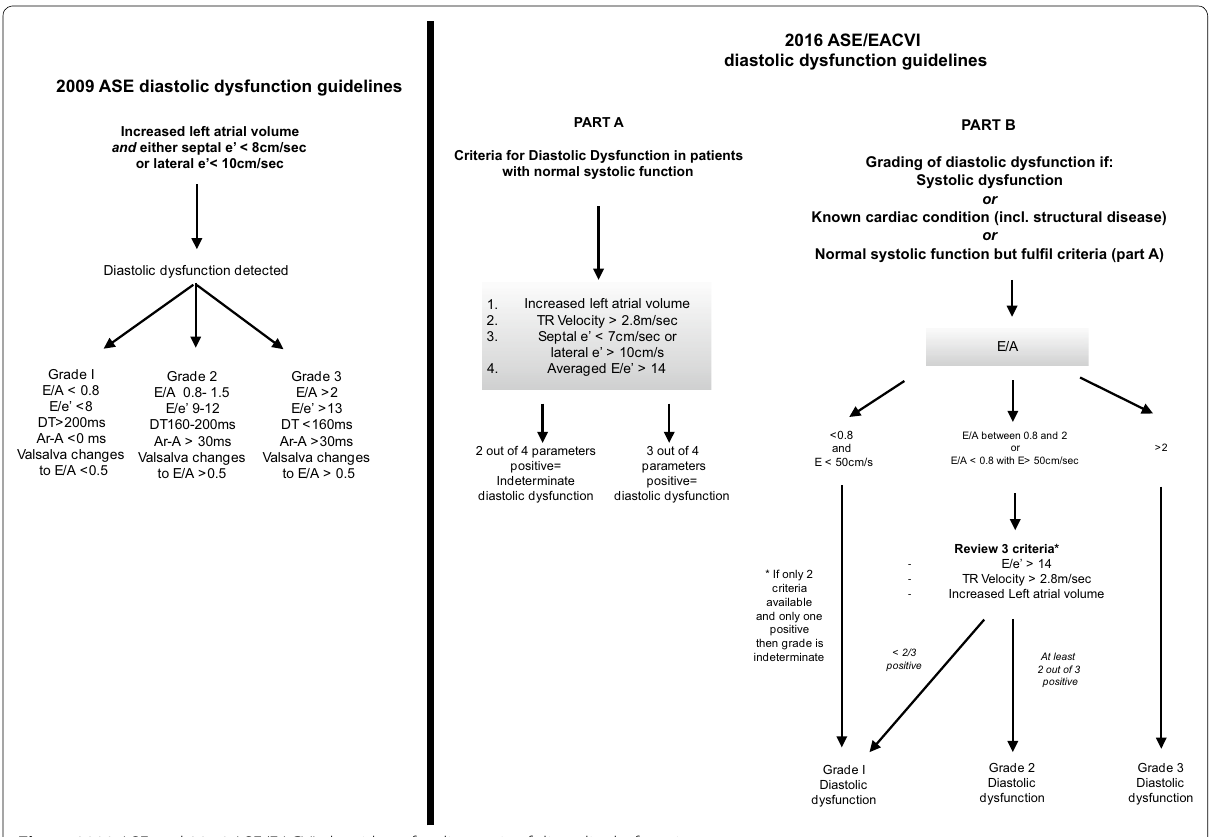
Fig. 1 2009 ASE and 2016 ASE/EACVI algorithms for diagnosis of diastolic